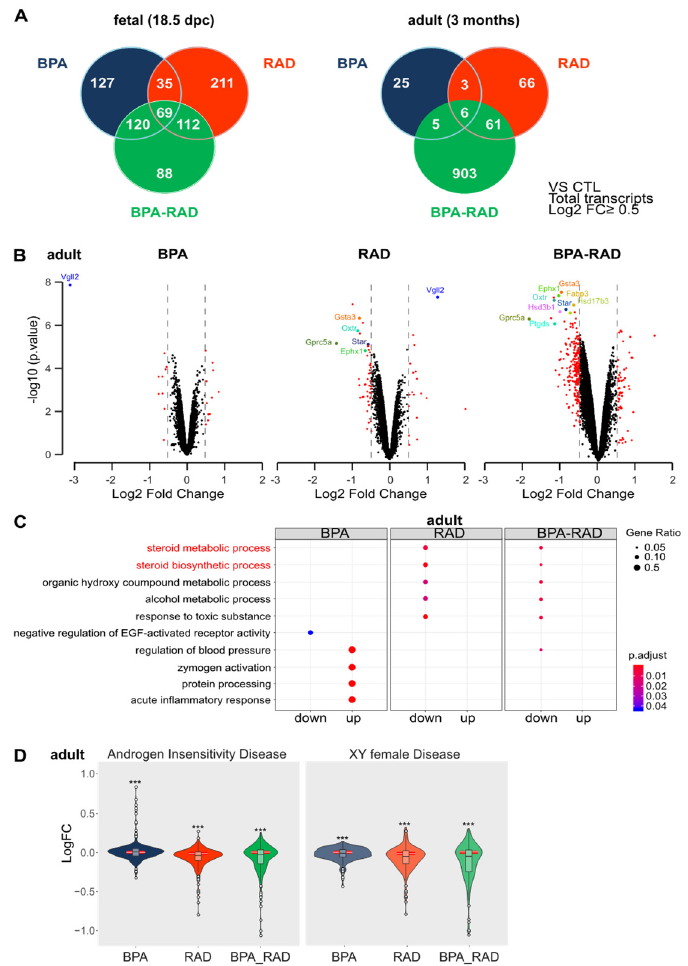
Figure 2. BPA and RAD co-exposure in utero synergistically increase the number of differentially expressed genes (DEGs) in the adult testis. Fetal (18.5 dpc) and adult (3 months) testes from exposed mice (BPA, RAD or combined exposure) or unexposed (CTL as control) mice were collected for transcriptome analyses. ( A ) Venn diagram of DEGs (all transcripts, log2 FC ≥ 0.5) in treated testes vs. control testes. ( B ) Visualization of the DEGs (protein coding mRNA, log2 FC ≥ 0.5) by volcano plots. ( C ) Group comparison of gene ontology biological process categories of significantly downregulated (down) or upregulated (up) genes (protein coding mRNA, Log2 FC ≥ 0.5) between exposed conditions (BPA, RAD or BPA-RAD) and the control (ETOH) group in adult testes. ( D ) Violin plot of LogFC expression of genes included in the gene sets associated with XY female disease and androgen insensitivity syndrome. Blue, orange or green boxplots represent the interquartile range and median value of the distribution of LogFC in the BPA, RAD and BPA-RAD conditions, respectively. A red rectangle with a white line underneath the box plot represents the interquartile range (red box) and median (white line) of a cohort of unbiased gene sets sampled by simple random sampling of the global gene list. *** p value < 0.001 by one-sample t -test.